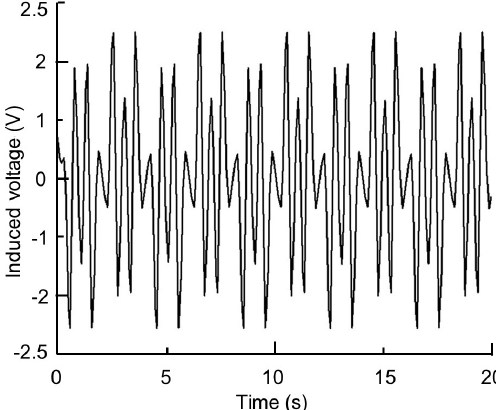
Figure 19. No load voltage curve.